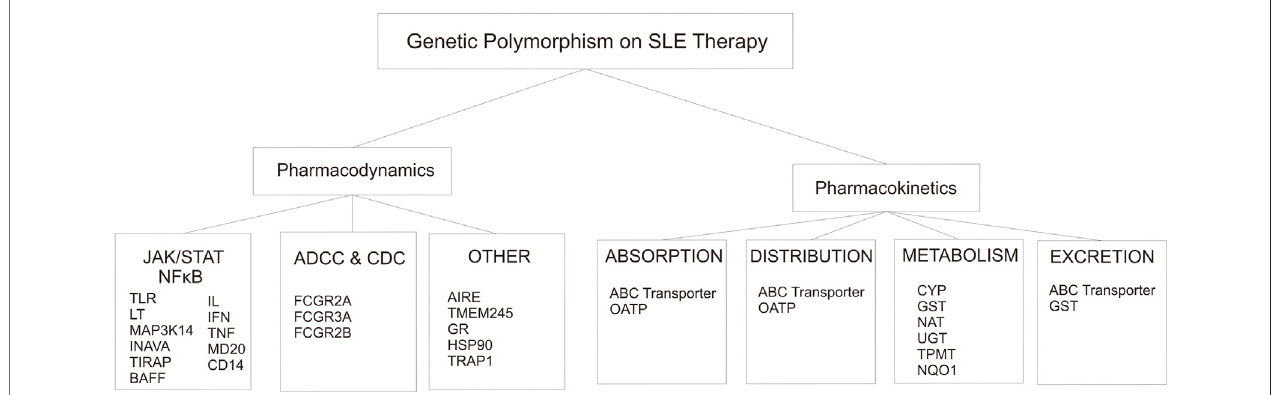
FIGURE 5 | Genetic Polymorphism that involved in the alteration of pharmacodynamics and pharmacokinetics on SLE therapy.